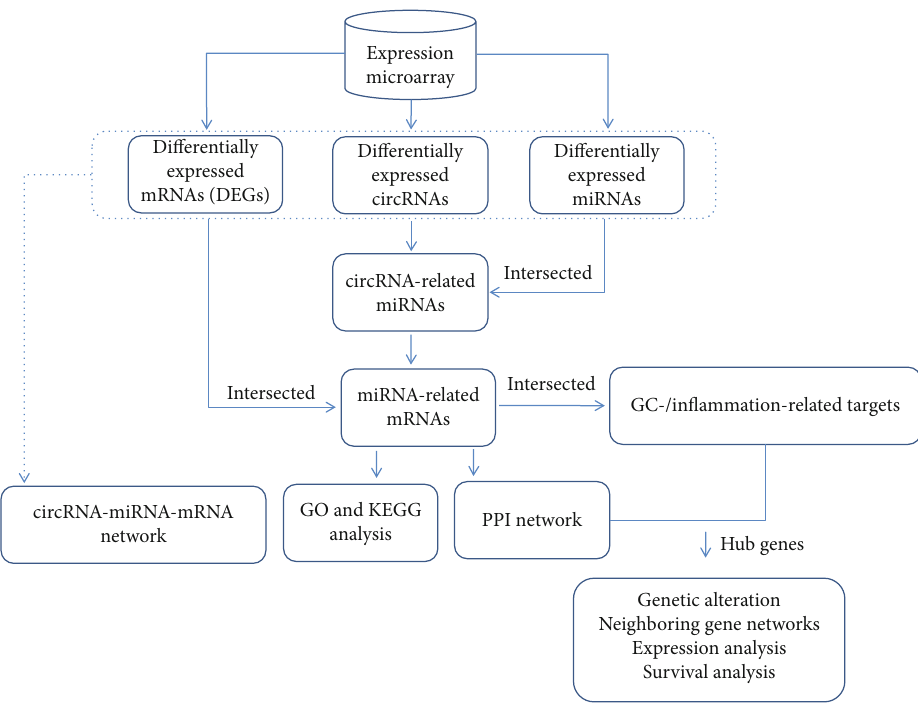
Figure 1: Work fl ow for the identi fi cation and analysis of hub genes in gastric